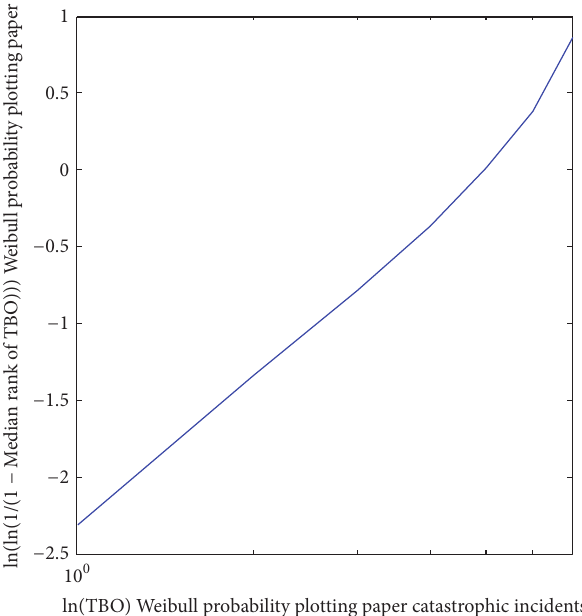
Figure 4: Weibull paper for catastrophic incident 2010 to 2015.